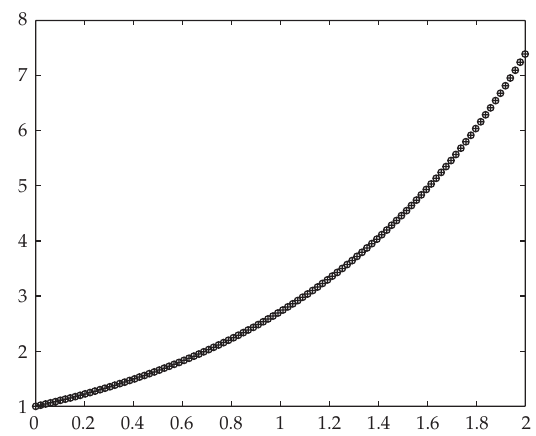
Figure 3: Index 2, T (cid:8) 2, the y 1 -coordinate, “o”-original, “ (cid:9) ”-approximation.